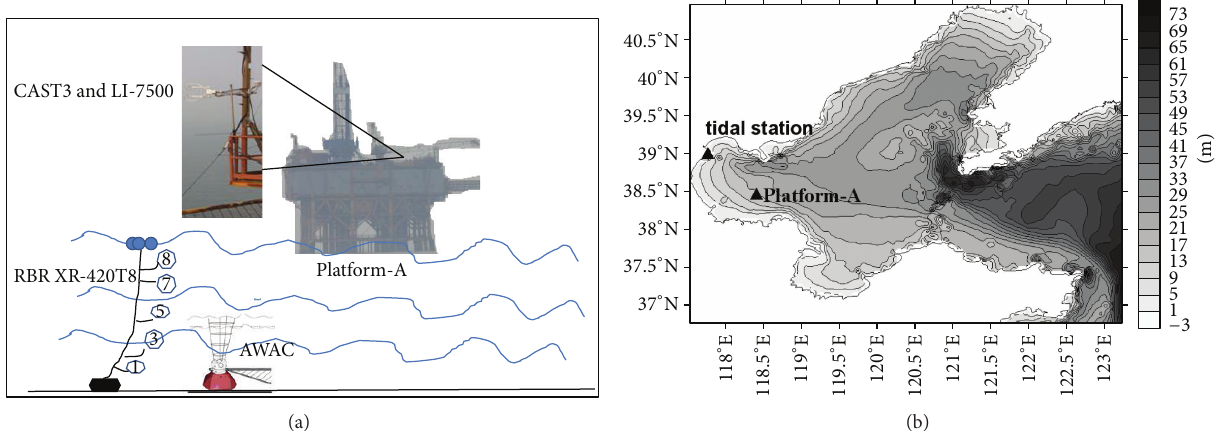
Figure 1: Platform-A in the Bohai Gulf and related observation instruments (a). Tide gauge station and Platform-A and water level (b).